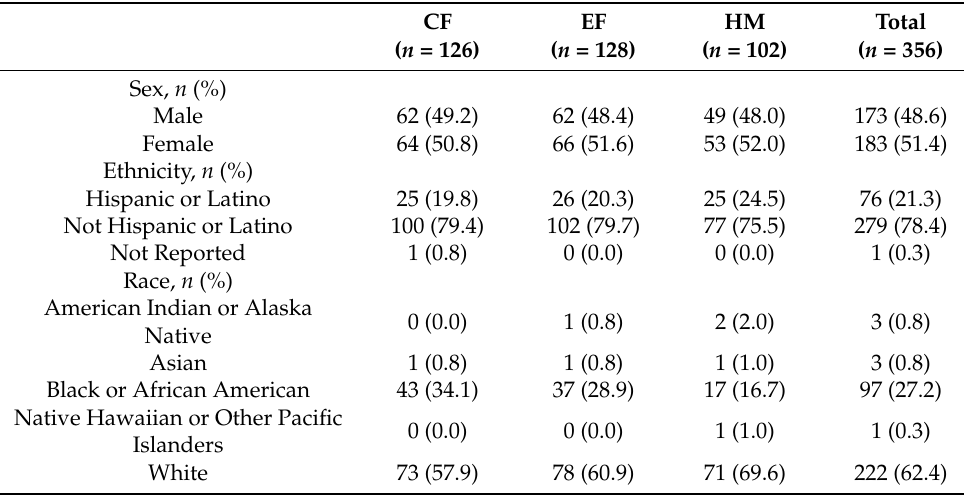
Table 1. Demographic Data for Study Participants